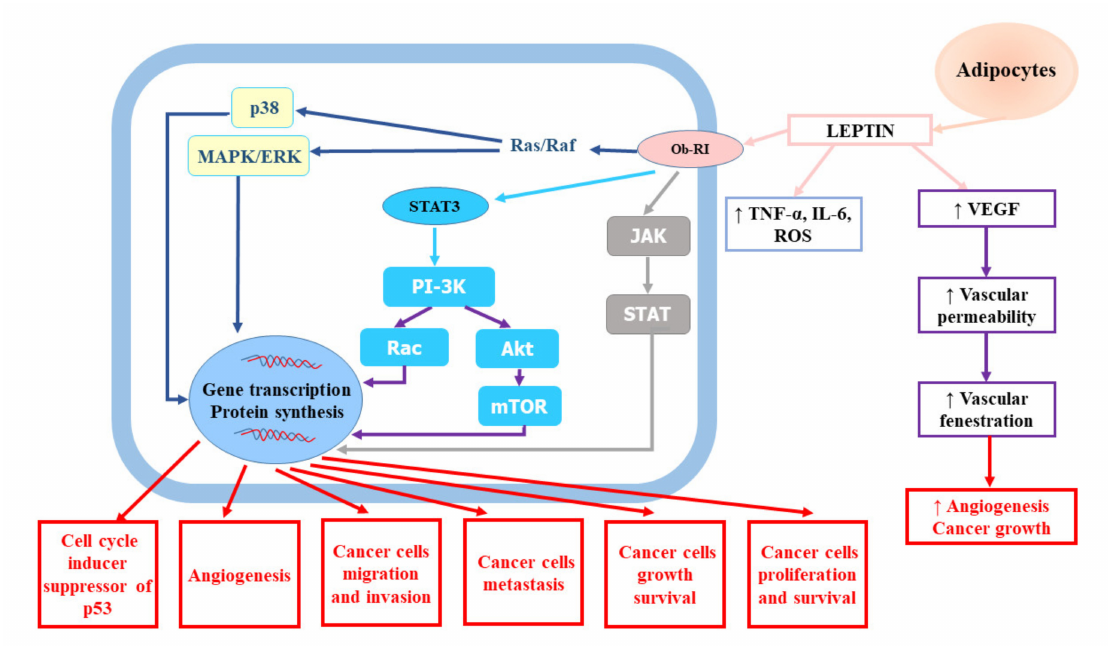
Figure 1. The role of leptin in renal cell cancer development and progression. Akt, protein kinase B; IL-6, interleukin-6; JAK, Janus kinase; MAPK / ERK, mitogen-activated protein kinase / extracellular- signal-regulated kinase; mTOR, mammalian target of rapamycin; Ob-RI, leptin or obesity receptor; PI-3K, phosphatidyl inositol 3-kinase; ROS, reactive oxygen species; STAT3, signal transducer and activator of transcription 3; TNF- α , tumour necrosis factor- α ; VEGF, vascular endothelial growth